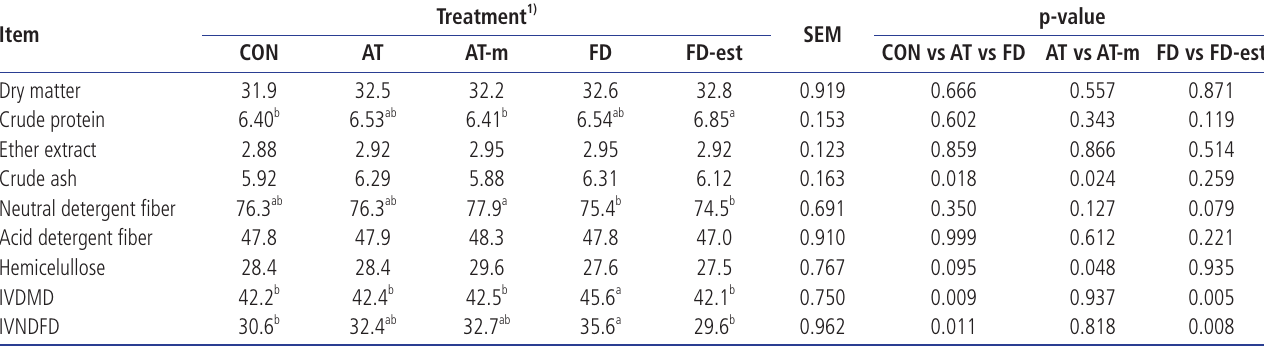
Table 2. Effects of wild and mutated inoculants on chemical compositions and in vitro digestibility of rye silage ensiled for 90 d (%, dry matter) Item